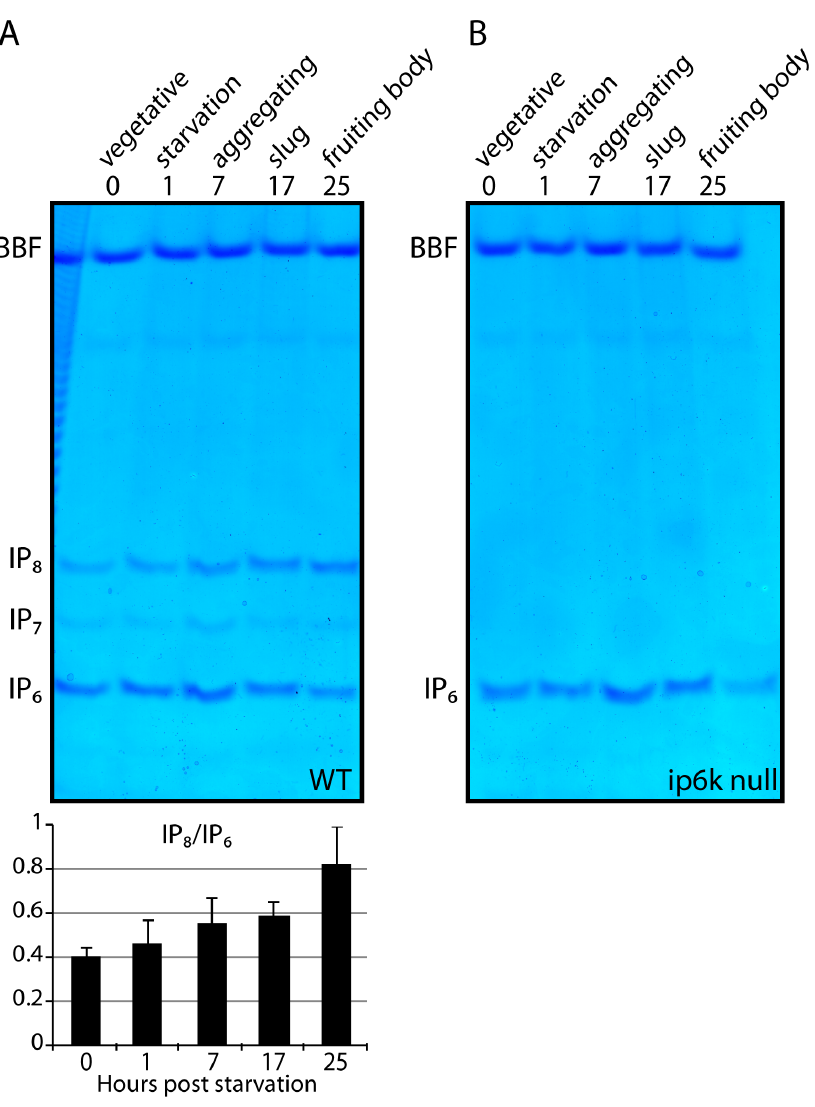
Figure 5. PAGE analysis of inositol pyrophosphate during D.Discoideum development. Amoeba development program was induced as described in material and methods. The inositol phosphates extracted at the indicated time points were resolved on 35% PAGE and visualised with Toluidine. (A) The analysis of wild type (WT) D. discoideum developmental program reveal a 2.6fold increase in the IP 8 /IP 6 ratio at the late stage of development, as quantified by densitometry quantified (Bottom), average + / 2 SD of four independent experiments. (B) To the contrary inositol pyrophosphates are not induced during IP 6 -Kinase (ip6k null) developmental program. The figure shows the result of a representative experiment that was repeated four times for the WT and two times for ip6k1